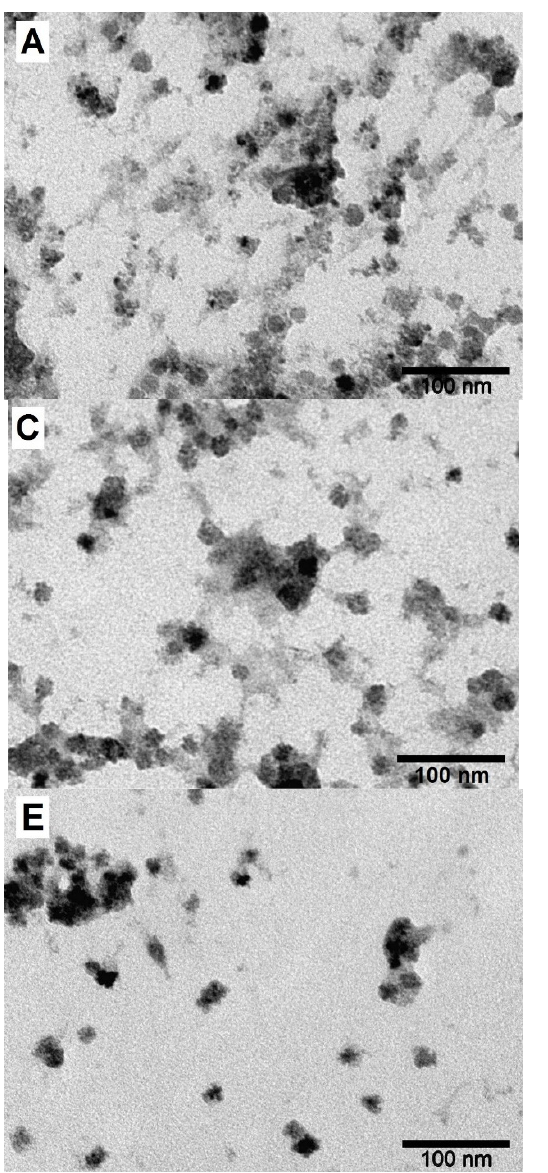
nm and 7.4 ± 0.7 nm to 13.7 ± 1.4 nm and 9.0 ± 0.9 nm, respectively. This happened because of magnetic core recrystallization during annealing. It did not take place for the x = 0.0- BT, probably because of the smaller initial mismatch between crystallite size and the size measured by TEM analysis. All barium titanates are crystallized in the tetragonal phase— the phase, which has prominent ferroelectric properties—with crystallite sizes of 10.1 ± 1.0 nm, 13.9 ± 1.4 nm, and 14.5 ± 1.5 nm for x = 0.0-BT, x = 0.5-BT and x = 1.0-BT, respectively.